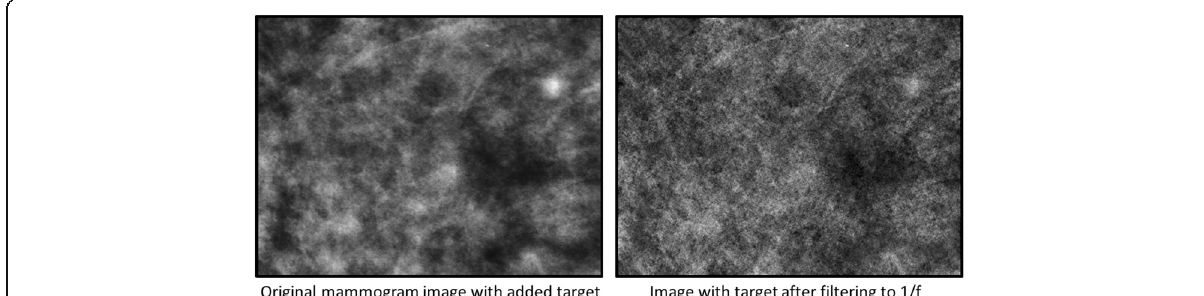
Fig. 2 Left : original mammogram image section with a target (Gaussian blob) added in the upper right quadrant . The original image has a slope of − 1.5. Right : the image and target after filtering to a slope of −